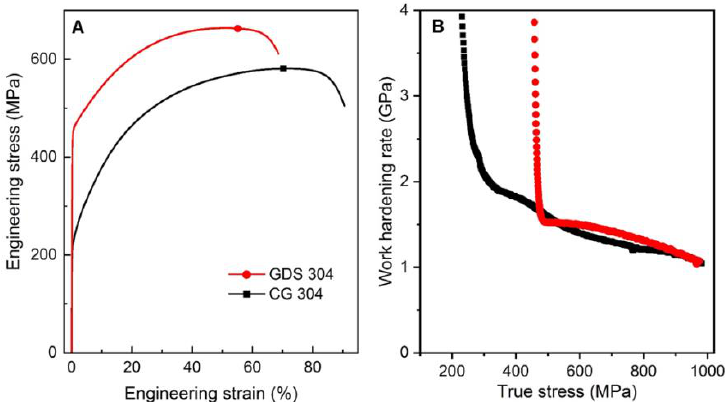
Figure 2. Tensile engineering stress – strain curves ( A ) and the corresponding work hardening rate- true stress relations ( B ) of GDS and dislocation-free CG 304 SS samples.